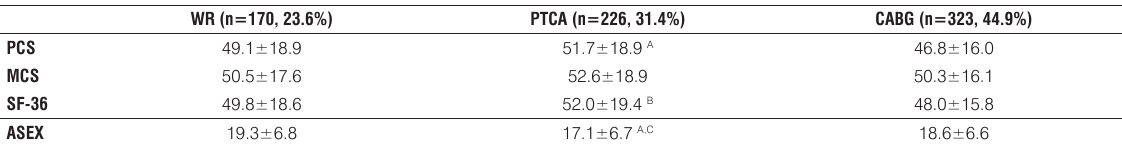
Table 5. HRQoL and ASEX in relation to treatment strategy.